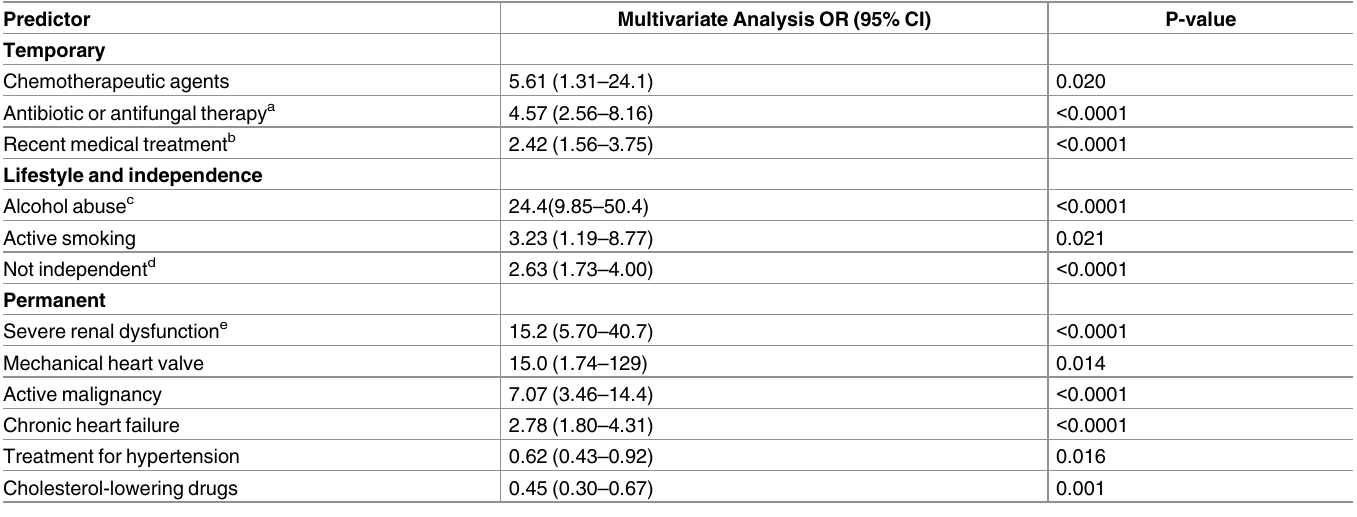
Table 2. The Multivariate Predictors of Excessive Warfarin